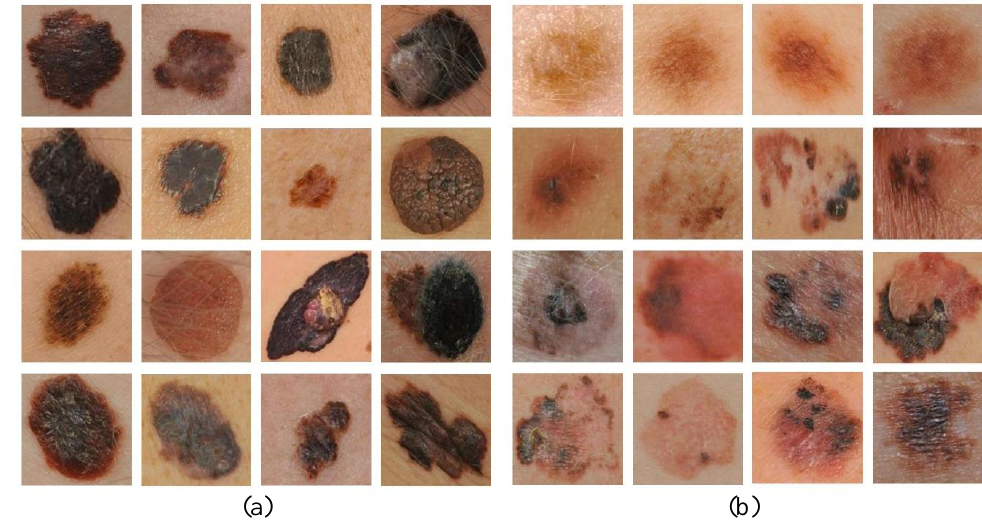
Figure 4. Examples of ( a ) correctly classified and ( b ) misclassified dermoscopy images. The confusion matrices of the classification results for the SVM, GAB, and kNN models are shown in Figures 5–7, respectively, using different feature selection methods (i.e., HOG, CS-HOG, LBP, and N-LBP).